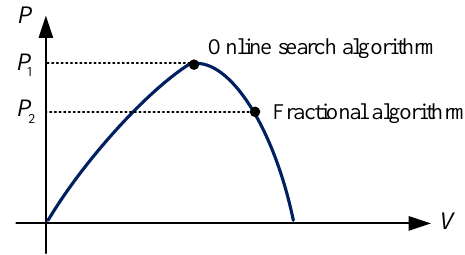
Figure 8. Combination of algorithms for tracking different operating points on the P-V curve.